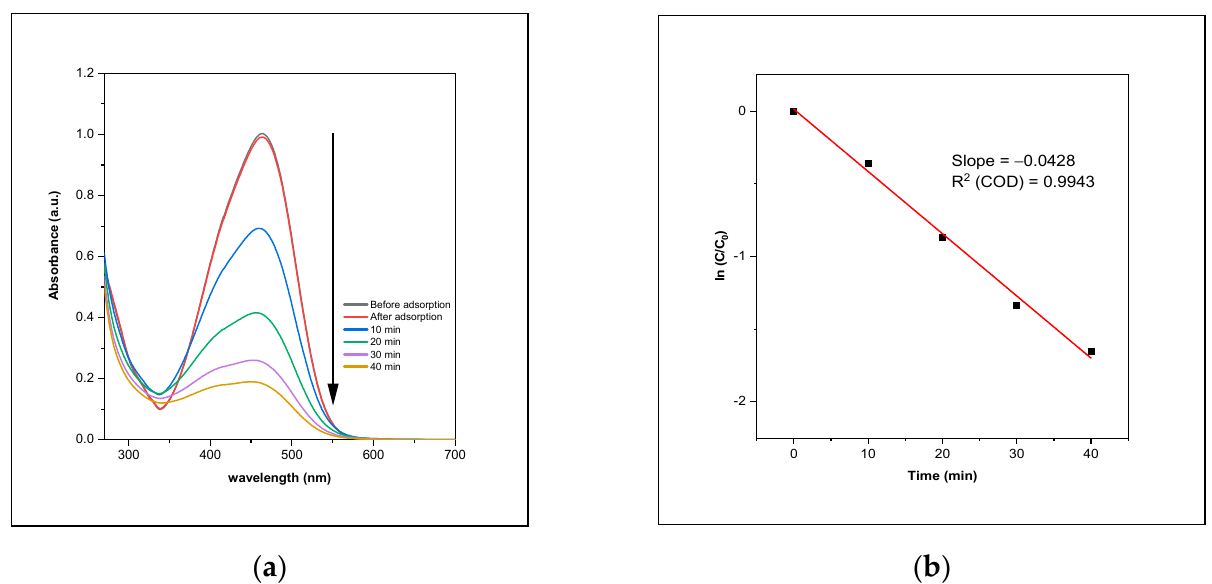
Figure 4. ( a ) UV-vis absorption spectra and ( b ) kinetics study of MO dye photocatalytic degradation. Upon UV irradiation, the electrons in the valence band of the photocatalyst moved into the conduction band. This resulted in the continuous generation of holes (h + ) in the valence band and electrons (e − ) in the conduction band. The generation of electron-hole pairs contributed to the activity of the photocatalyst. Holes with high oxidative